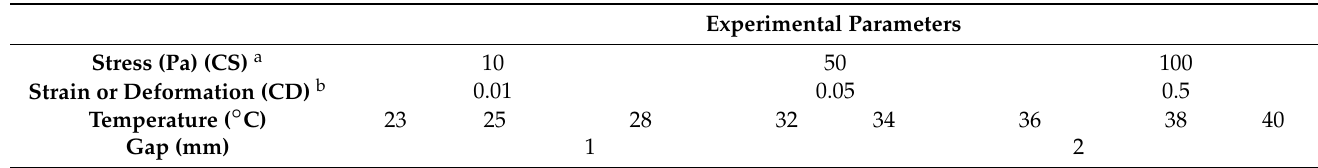
Table 1. Constant experimental test parameters used for collagen gels under stress or deformation